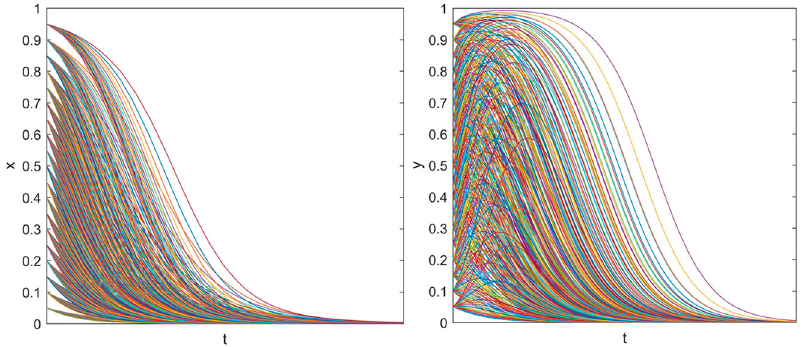
Figure 10. Strategies’ evolutions of the grid company and user over time in Case 3.